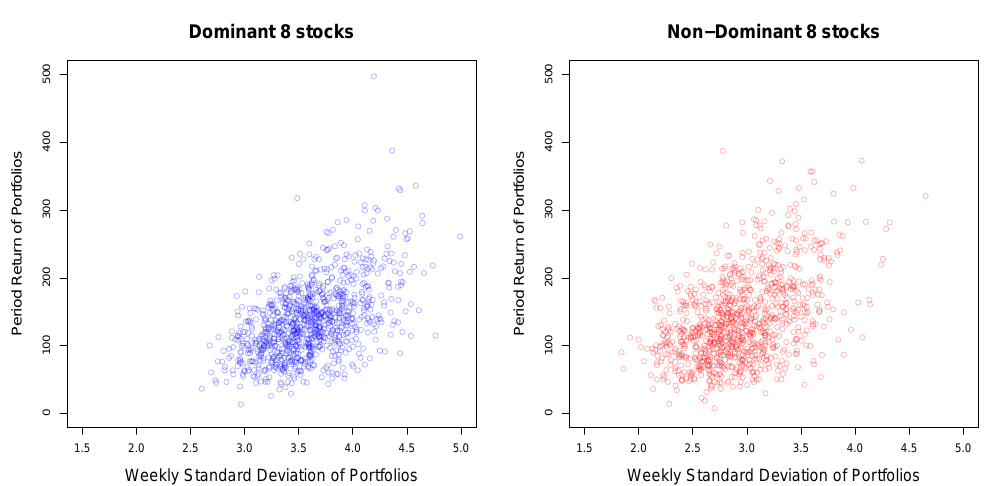
Figure 10. Scatter plots of Period 5 returns against the weekly volatility for the eight-stock portfolios selected on the basis of the clusters identified in neighbor-Nets splits graph from Period 4 with the clusters split into dominant and non-dominant industry